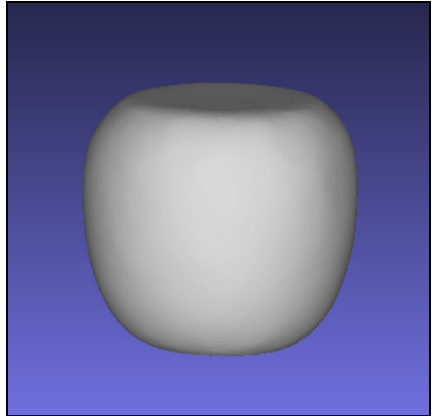
Fig.10. Reconstructed Surface Model of Cylinder Shape Case Study.